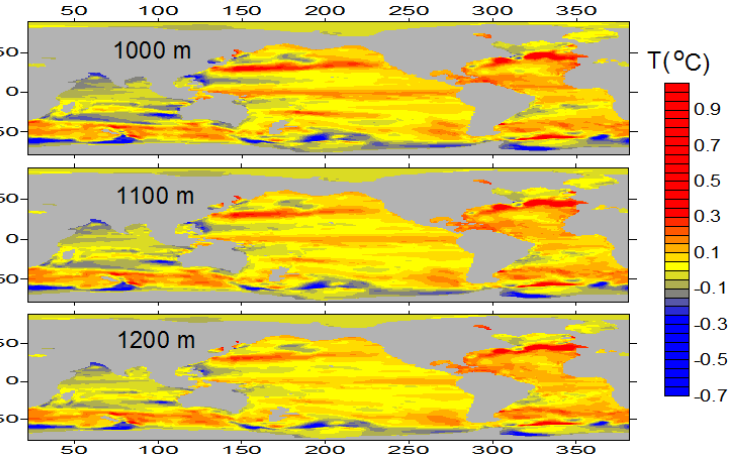
Figure 8. Perturbations in the WO temperature (°C) in the deep layer (levels 1000, 1100, 1200 m) from the phase of 1948–1974 to the phase of